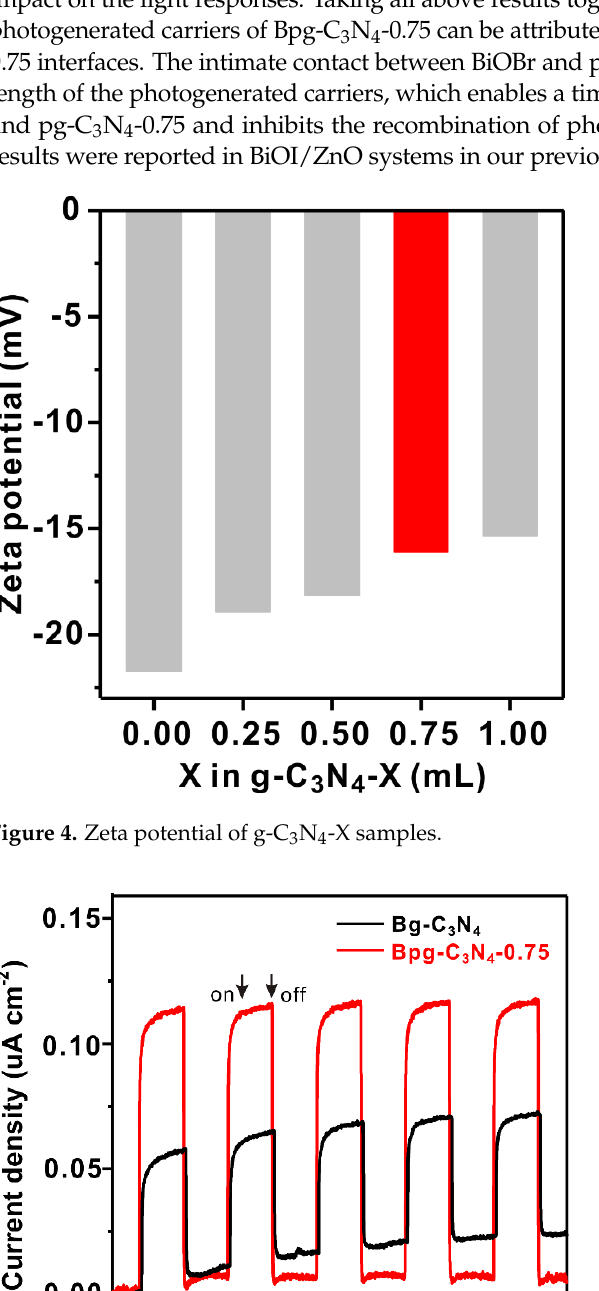
Figure 6. ( a ) Bi 4 f spectra and ( b ) UV-Vis spectra of Bg-C 3 N 4 and Bpg-C 3 N 4 -0.75. The photocatalytic activities of the BiOBr/g-C 3 N 4 heterojunctions were evaluated by the degradation of RhB under visible-light irradiation. As indicated in Figure 7a, both pure g-C 3 N 4 and pg-C 3 N 4 -0.75 exhibit poor photocatalytic activity toward RhB degradation (less than 10% within 60 min). However, once BiOBr is loaded, the pho- tocatalytic activity is considerably promoted. Bg-C 3 N 4 degrades 50% of RhB within 60 min, which is significantly higher than that of g-C 3 N 4 . This improved activity orig- inates from the formation of BiOBr/g-C 3 N 4 heterojunctions, which facilitate the sep- aration and transfer of photogenerated carriers. For the catalysts with BiOBr/g-C 3 N 4 heterojunctions, the catalytic performance is determined by the different structure of g-C 3 N 4 . As shown in Figure 7a, the catalytic performance of BiOBr/g-C 3 N 4 follows the trend of Bg-C 3 N 4 < Bpg-C 3 N 4 -0.25 < Bpg-C 3 N 4 -0.50 < Bpg-C 3 N 4 -0.75 > Bpg-C 3 N 4 -